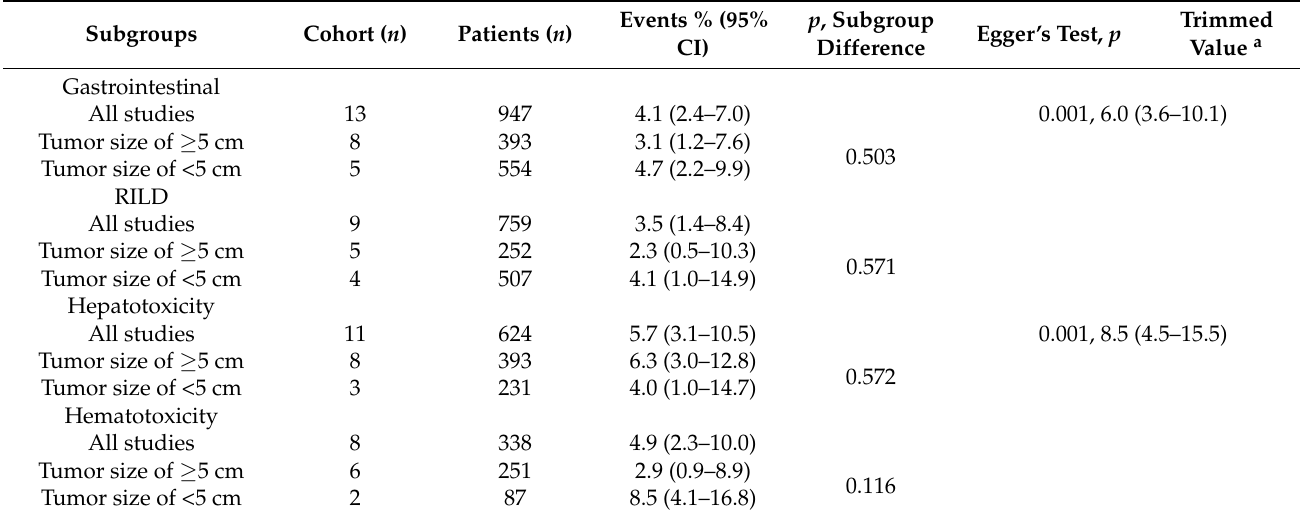
Table 4. Pooled analysis of grade ≥ 3